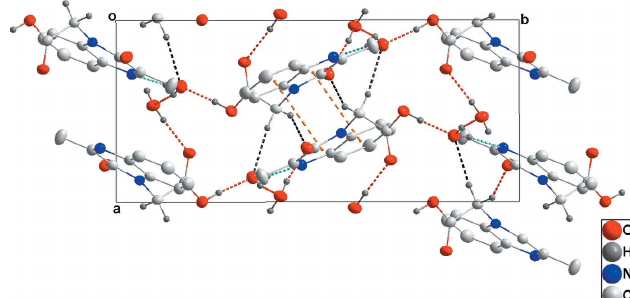
Figure 2 Packing diagram of the title compound viewed along the c axis with intermolecular interactions shown as in Fig. 2.